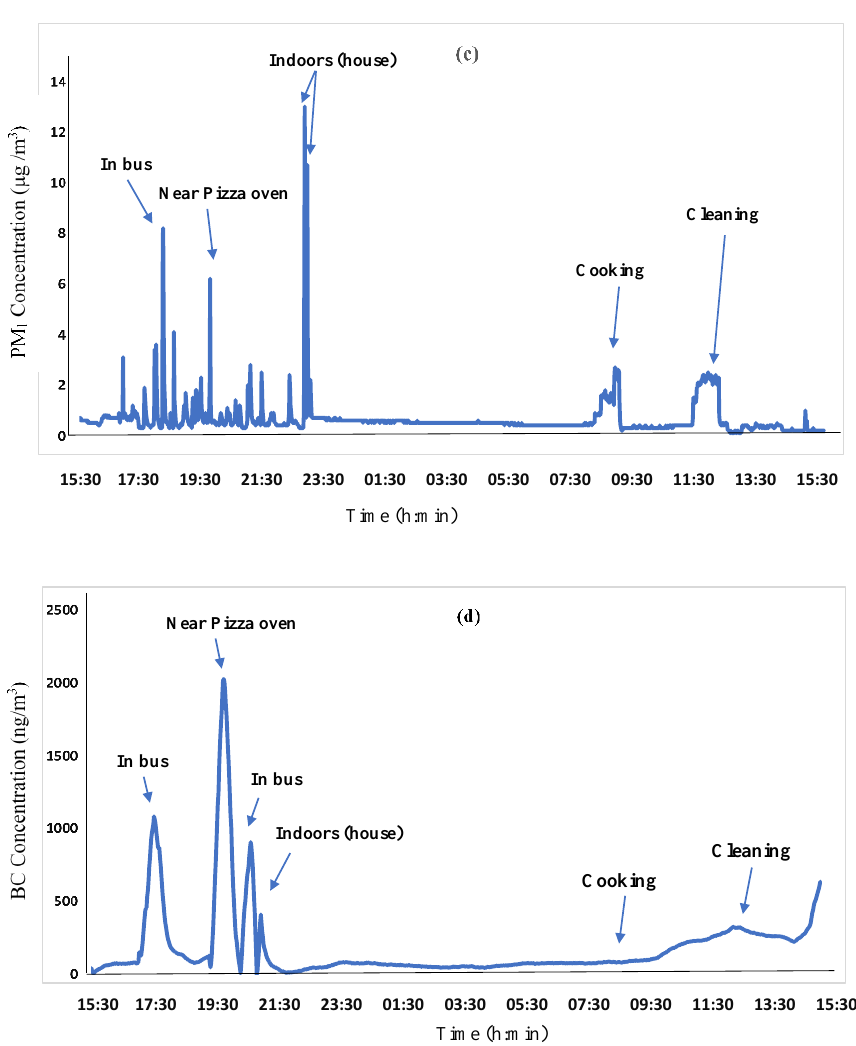
Figure 6. Exposure concentrations variations for 24 h in Albany (Campaign 7): ( a ) PM 10 , ( b ) PM 2.5 , ( c ) PM 1 , and ( d ) BC.